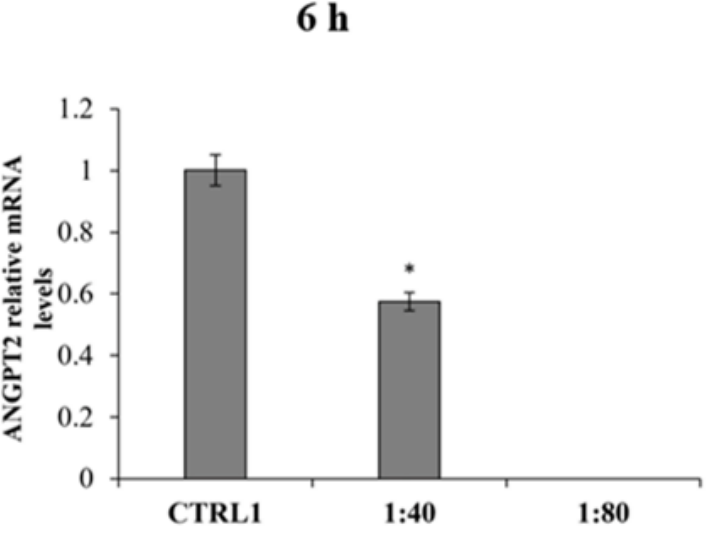
Figure 9. Relative gene expression of Angiopoietin 2 (ANGPT2) in HGFs exposed to DMEM culture medium (CTRL1), to SS diluted 1:40 and 1:80 for 6 h. Data are expressed as relative to CTRL1 (calibrator sample, defined as 1). The most representative of three separate experiments is shown. The bar graph displays densitometric values expressed as mean ± standard deviation, Y-axis, fold change. vs. CTRL1 * p = 0.0135.